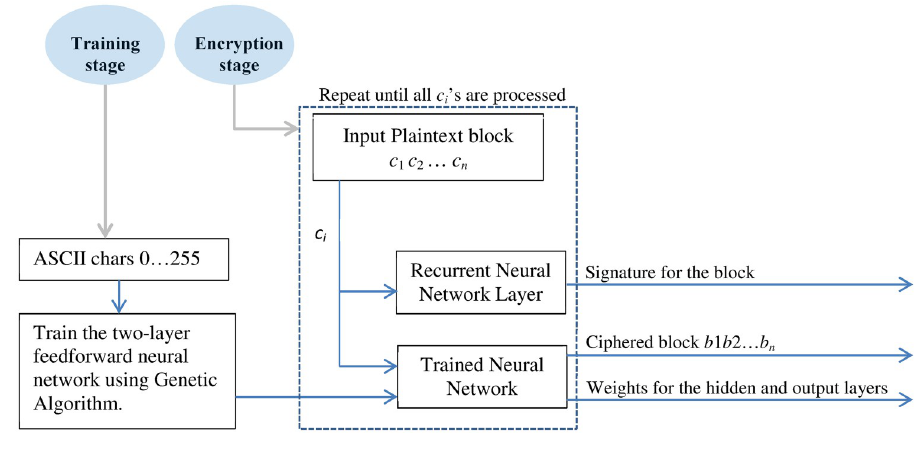
Fig 4. The encryption process using NN